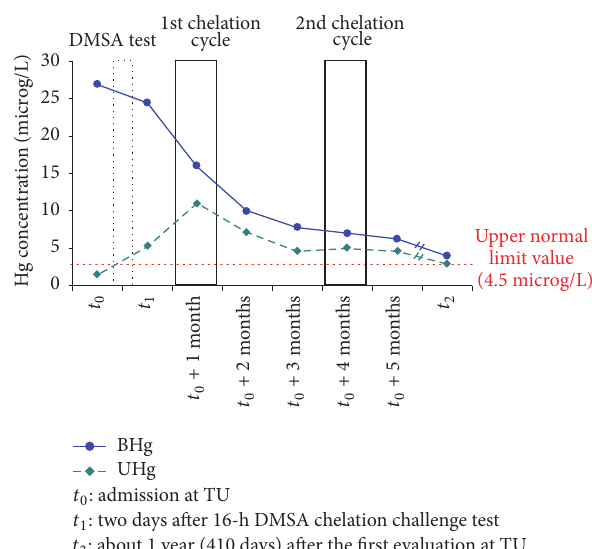
Figure 1: Hg concentration trends in different sampled matrices, that is, blood (BHg) and urine (UHg), throughout the entire biological monitoring 1-year period (from 𝑡 0 to 𝑡 2 ). The hatched bars indicate the 16-h chelation challenge test and the successive two DMSA